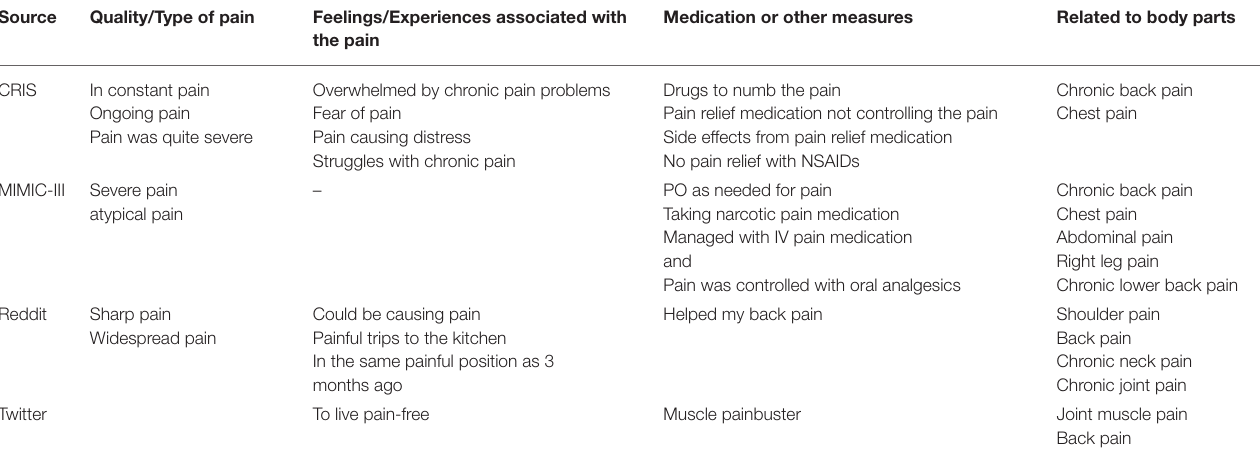
TABLE 2 | Length of text within documents containing the word “pain” in the 4 text sources on a random set of 50 documents for each text source. Source CRIS MIMIC Twitter Reddit Average length of text (charac.) Minimum length of text (charac.) Maximum length of text (charac.)